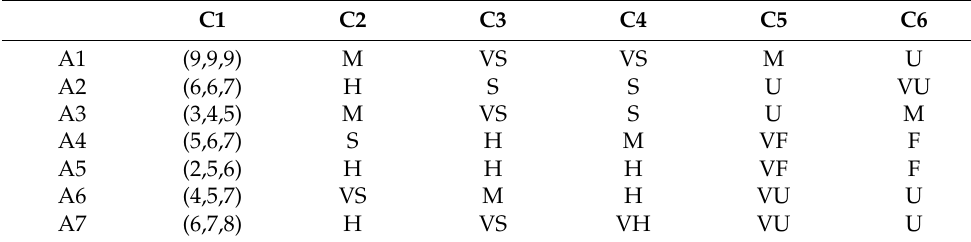
Table 5. Evaluation of alternatives by E4.